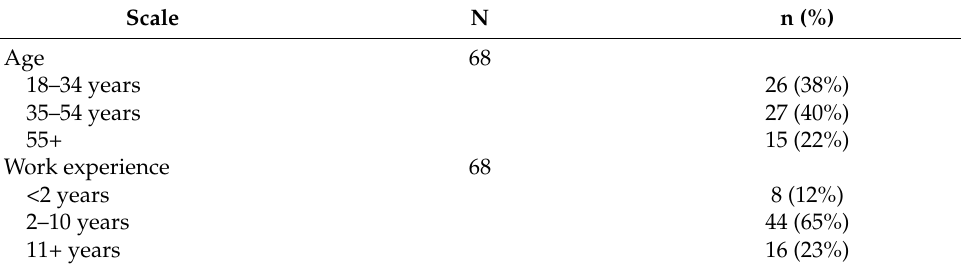
Table 1. Demographic